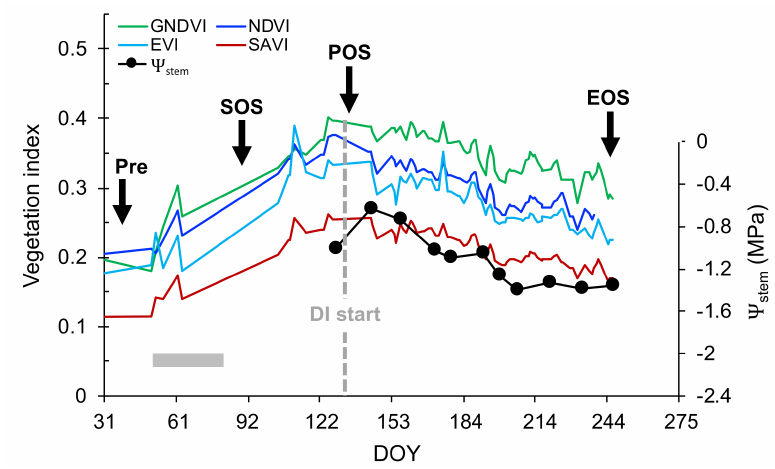
Figure 2. Daily time series of the four vegetation indices and weekly measured midday stem water potential ( Ψ stem ) along the grapevine growing season at Mevo Beitar (VIs are averaged values over all pixels within the vineyard area). Important phenological stages are shown (Pre—the pre-season period when vines are leafless and understory vegetation is absent or dry; SOS—start of season, coincident with budburst stage; POS—peak of season, corresponding to full bloom stage; EOS—end of season, the harvest stage). DI start is the date when deficit irrigation started (DOY 131). Horizontal grey bar indicates the period of expansive presence of understory weeds and grasses in the